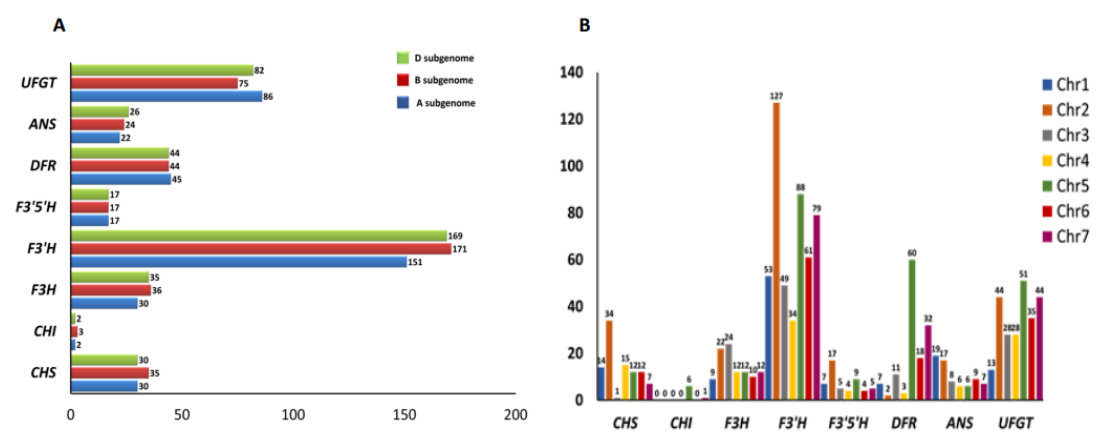
Figure 1. ( A ) Genomic and ( B ) chromosome distribution of genes of anthocyanin biosynthesis pathway in wheat.